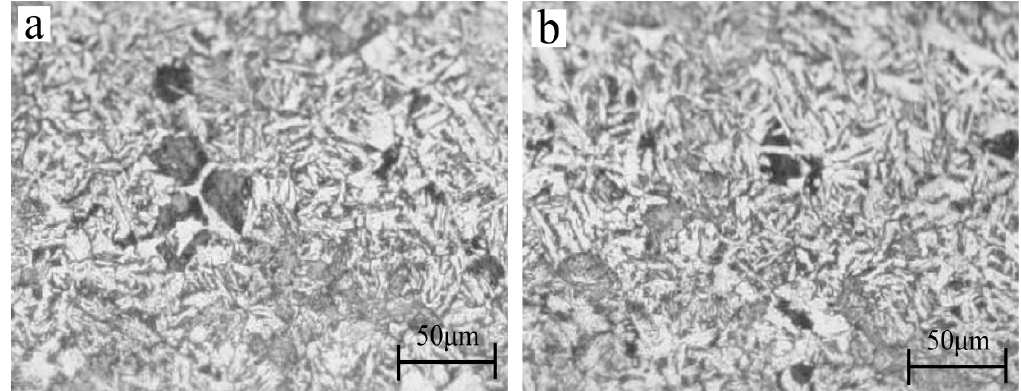
Figure 2. The martensite microstructure under the conditions of ( a ) grinding depth = 200 µ m, pre-stress = 67 MPa; ( b ) grinding depth = 200 µ m, pre-stress = 100 MPa.